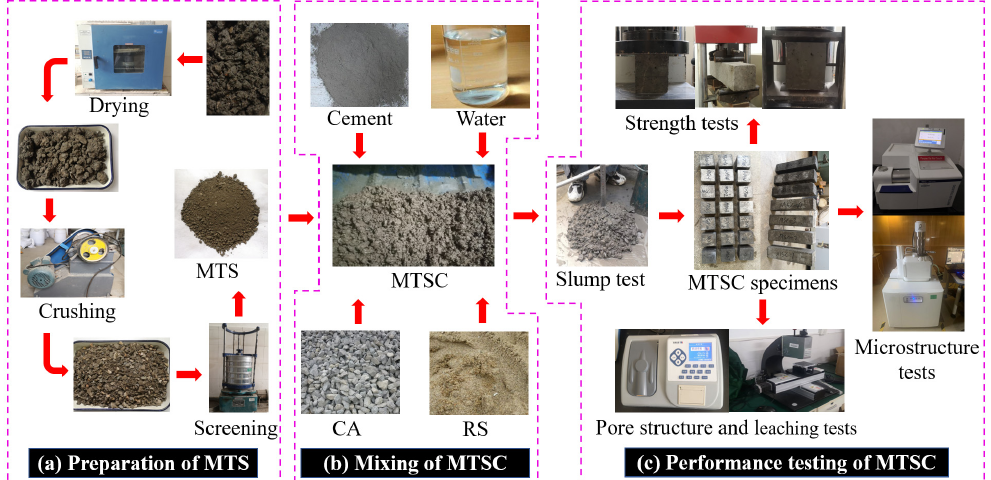
Figure 1. The gradation curves of RS and MTS.